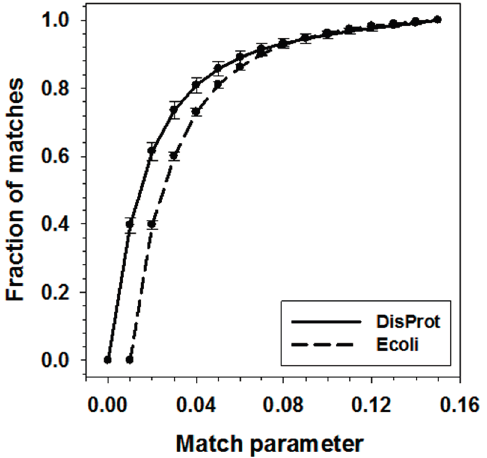
Figure 3. Match parameter influences fraction of identified matches. The averaged fraction of matches on one pair of sequences was calculated and then normalized in the datasets. Solid line and dash line are the correlation between match parameter and fraction of matches for DisProt and Yeast datasets,